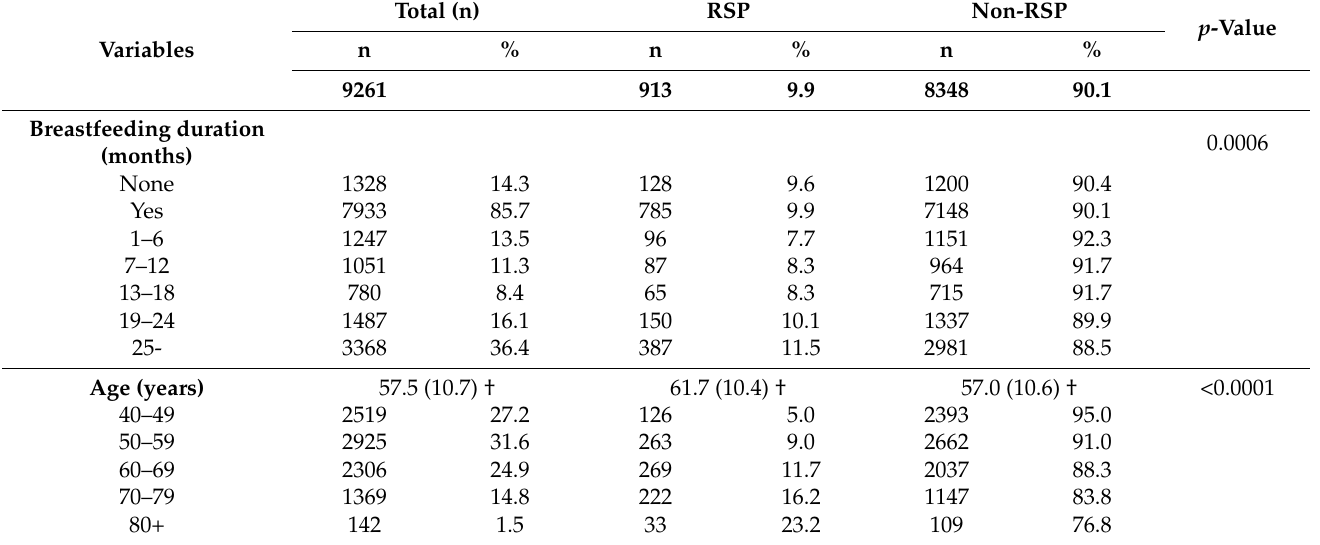
Table 1. Demographic characteristics of participants according to restrictive spirometric